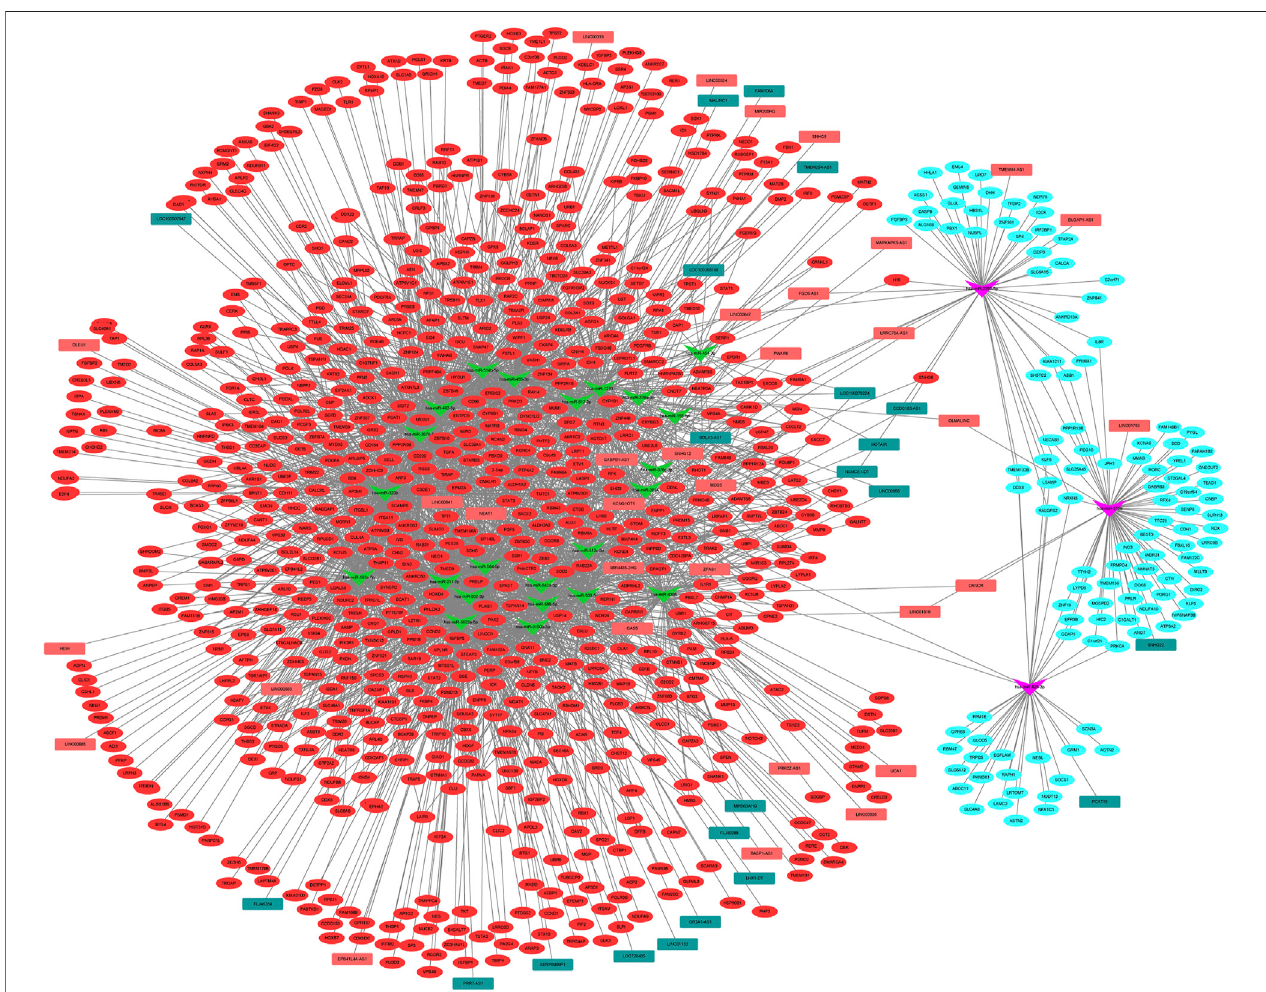
FIGURE 4 | lncRNA – miRNA – mRNA ceRNA network among DELs, DEMis, and DEMs in IDD. DEL: differentially expressed long non-coding RNAs; DEMi: differentially expressed microRNAs; DEMs: differentially expressed mRNAs; IDD: intervertebral disc degeneration; and ceRNA: competitive endogenous RNA.